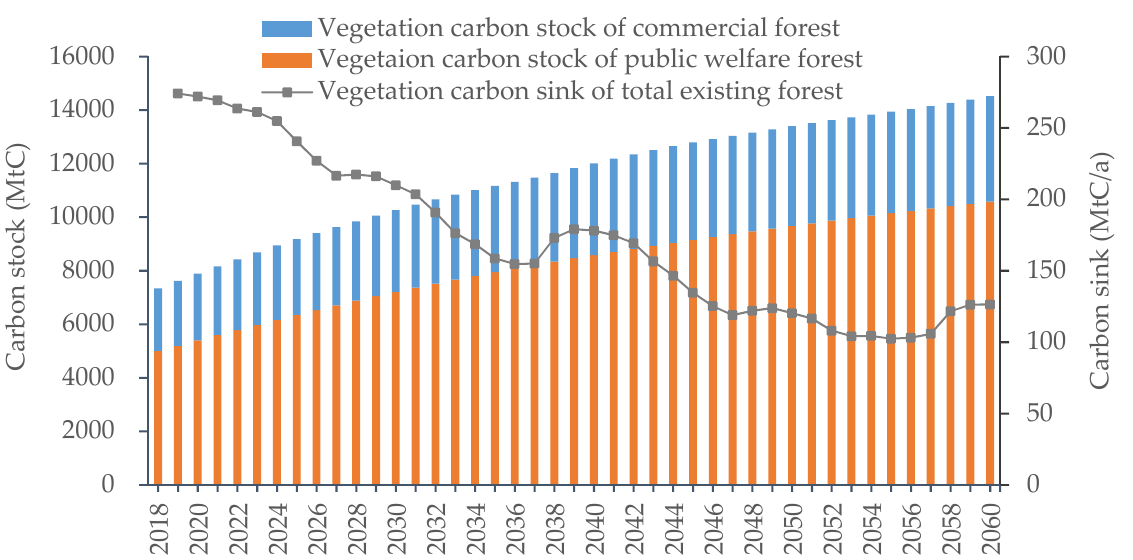
Figure 3. Vegetation carbon sink of China’s existing arbor forest.